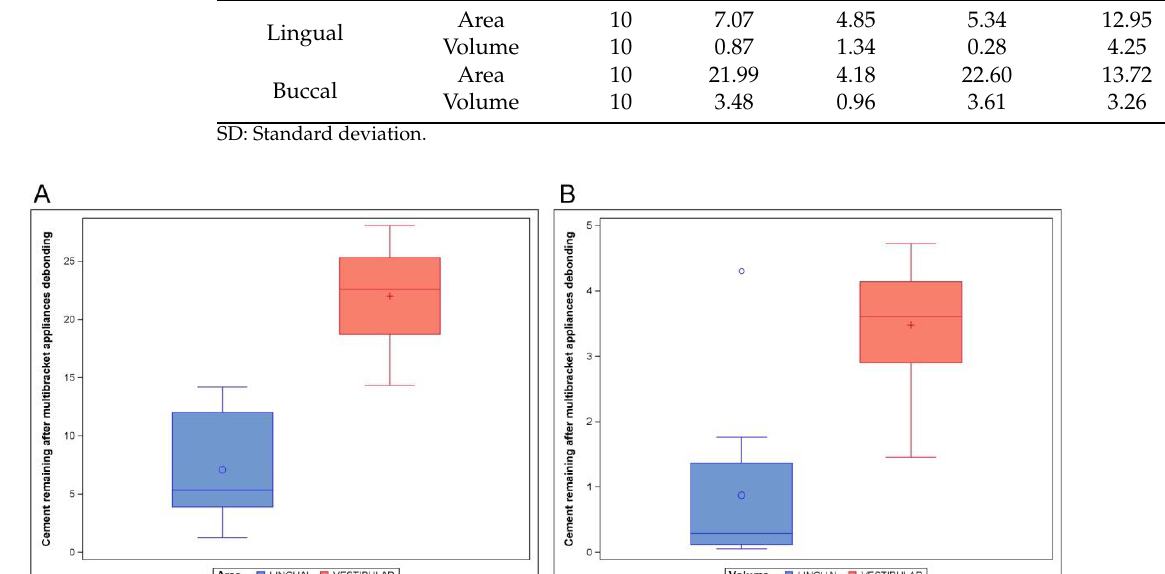
Figure 5. Boxplot of the area ( A ) and volume ( B ) of remaining cement after lingual and buccal multibracket appliance debonding. The horizontal line in each box represents the respective median value of the study groups. Blue represents lingual multibracket appliance and red represents buccal multibrackets appliance.